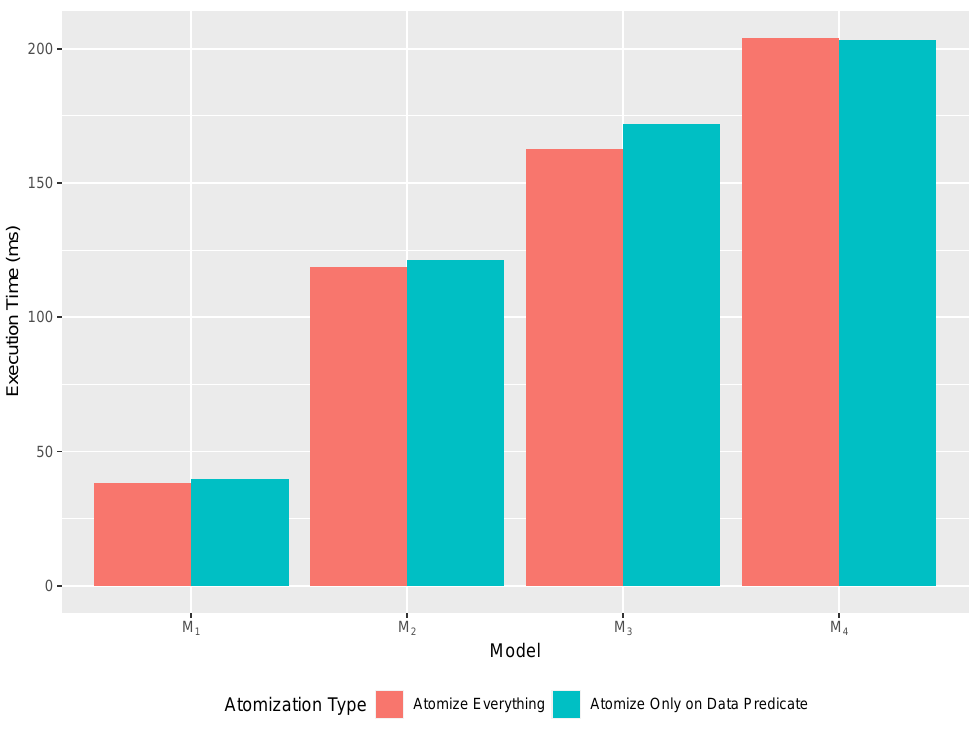
Figure 13. Running times over different models (Table S1a) for different atomisation